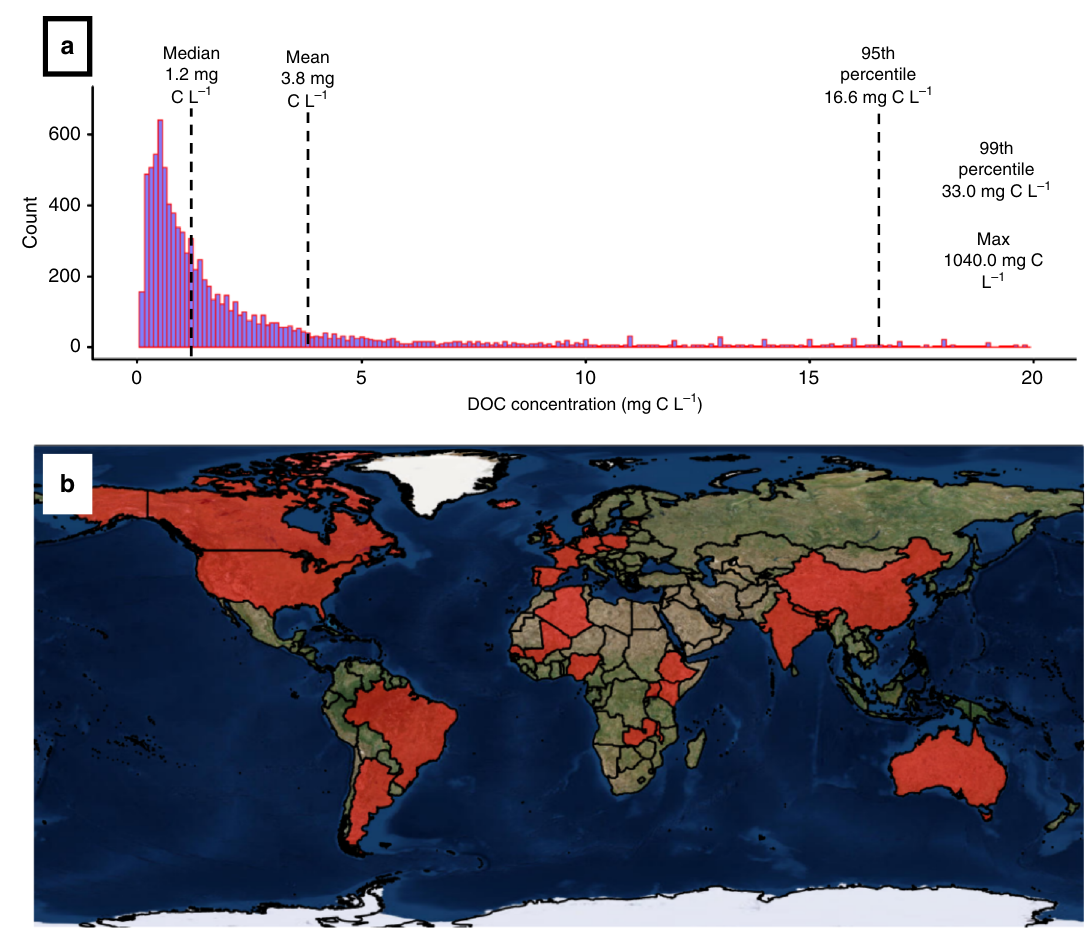
Fig. 1 Global groundwater DOC concentrations. a Histogram showing global groundwater DOC concentrations (mg C L − 1 ). Sample sizes for individual countries ranged from 5 to 5,812, with 14 out of 32 countries having n < 30. We have therefore presented aggregated data. Samples above 20 mg C L − 1 are not included in the graph for clarity ( n = 337). The black dashed lines indicate the global median (1.2 mg C L − 1 ) and mean (3.8 mg C L − 1 ) and 95th percentile (16.6 mg C L − 1 ) values, respectively. Also shown are the 99th percentile value and the maximum value (33.0 and 1040.0 mg C L − 1 , respectively). b Countries from which groundwater DOC data were obtained are shown in